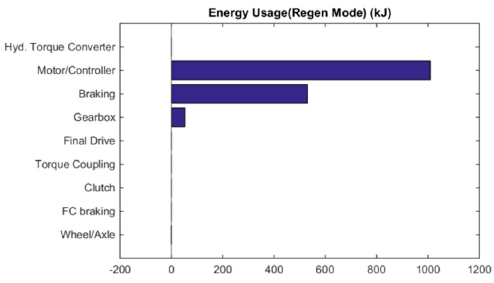
Energies 2020 , 13 , x FOR PEER REVIEW